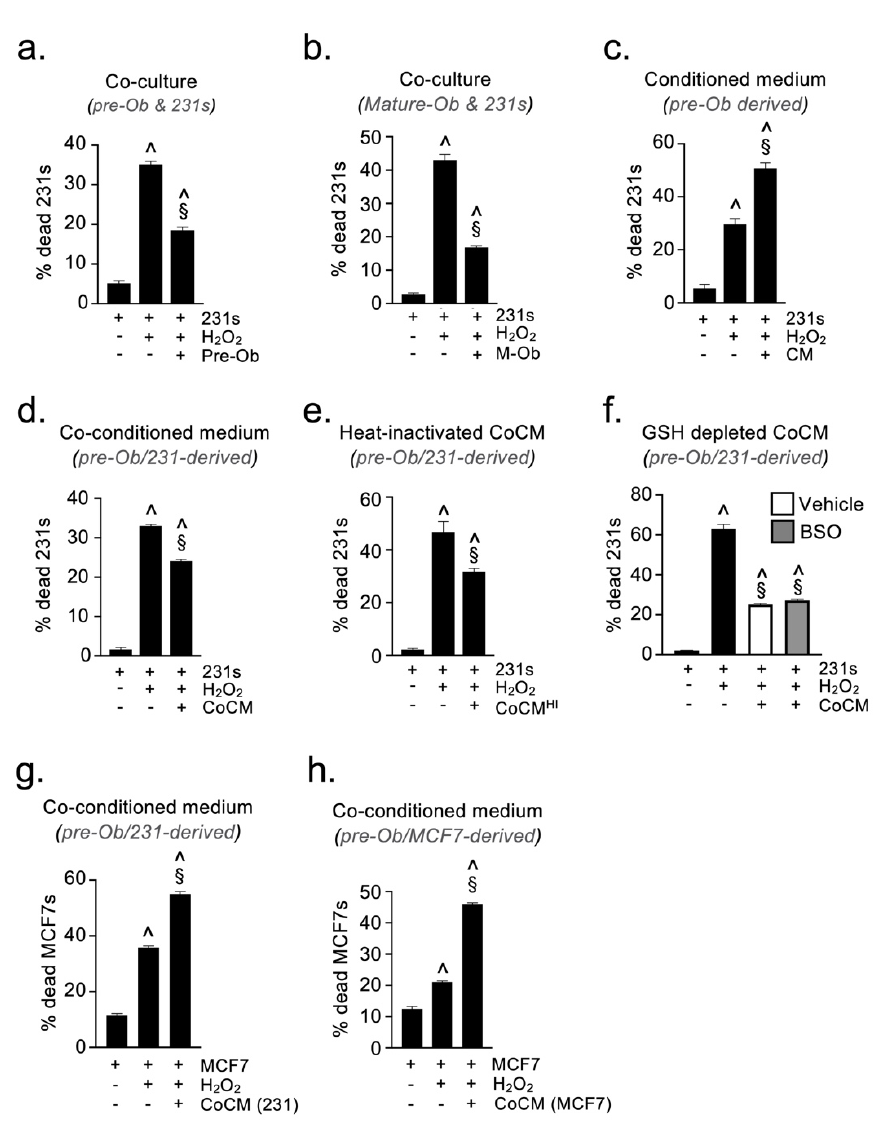
white) and quantification of osterix + osteoblastic cells in FOV containing DTCs “hotspots”. ( d ) Math- ematical calculation of the probability of developing tumor growth if all DTCs have an equal likeli- hood of death vs. proliferation (Model 1) and if proliferation is restricted to a subpopulation (11%) of DTCs (Model 2). Horizontal error bars are standard error of the mean and vertical error bars are based on the accuracy of published data. (OutG. = Outgrowth, Indol. = Indolence; ^ sig. dif. w.r.t.